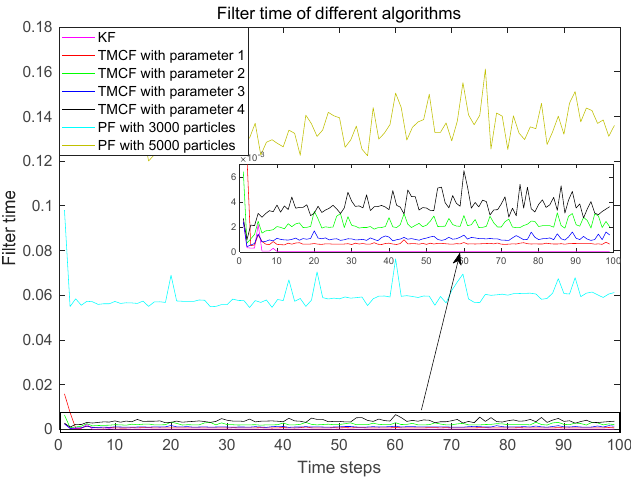
Figure 12. Computation time for the TMCF algorithm with different parameters. Table 3. Performance of the different filter algorithms with different parameters in the linear/Gaussian system. Algorithm